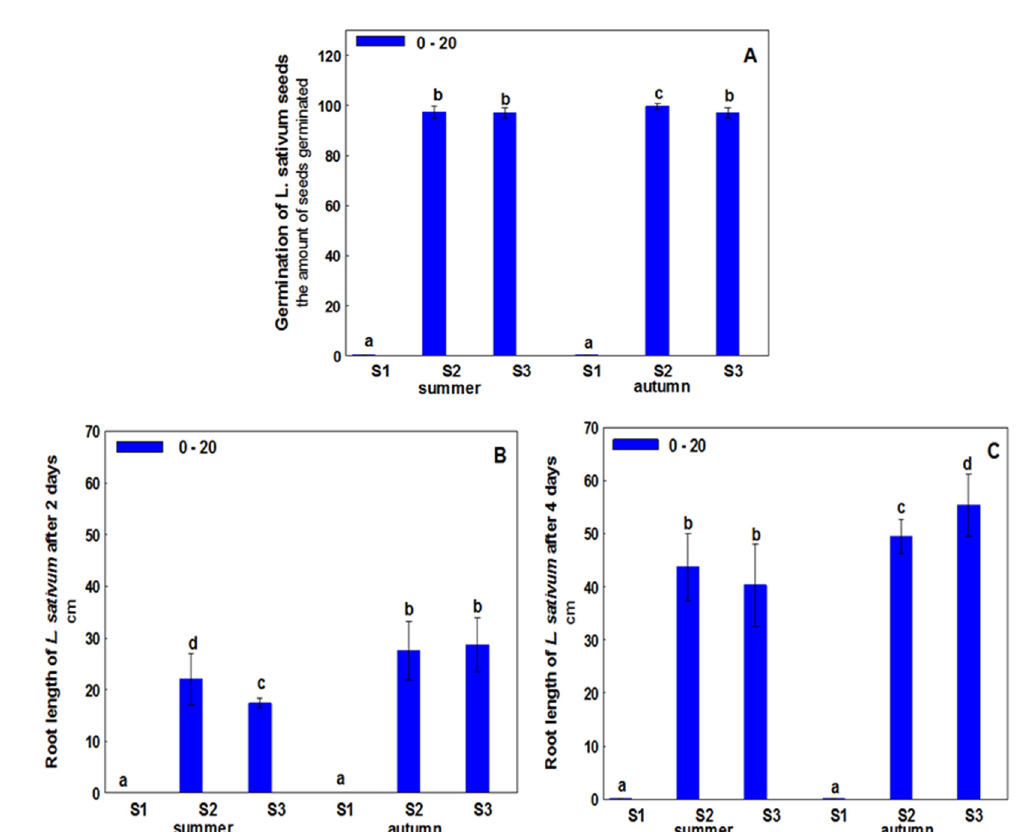
Figure 5. Soil phytotoxicity indicators from the 0–20 cm layer: ( A ) L. sativum seed germination; ( B ) seedling root length after 2 days; ( C ) seedling root length after 4 days. S1, S2, S3 —sampling sites located S1—5.88, S2—22.7 and S3—50.08 m from the reservoir with liquid post-production waste. Vertical lines indicate the standard deviation. Different letters above the columns indicate significant differences at p < 0.05.